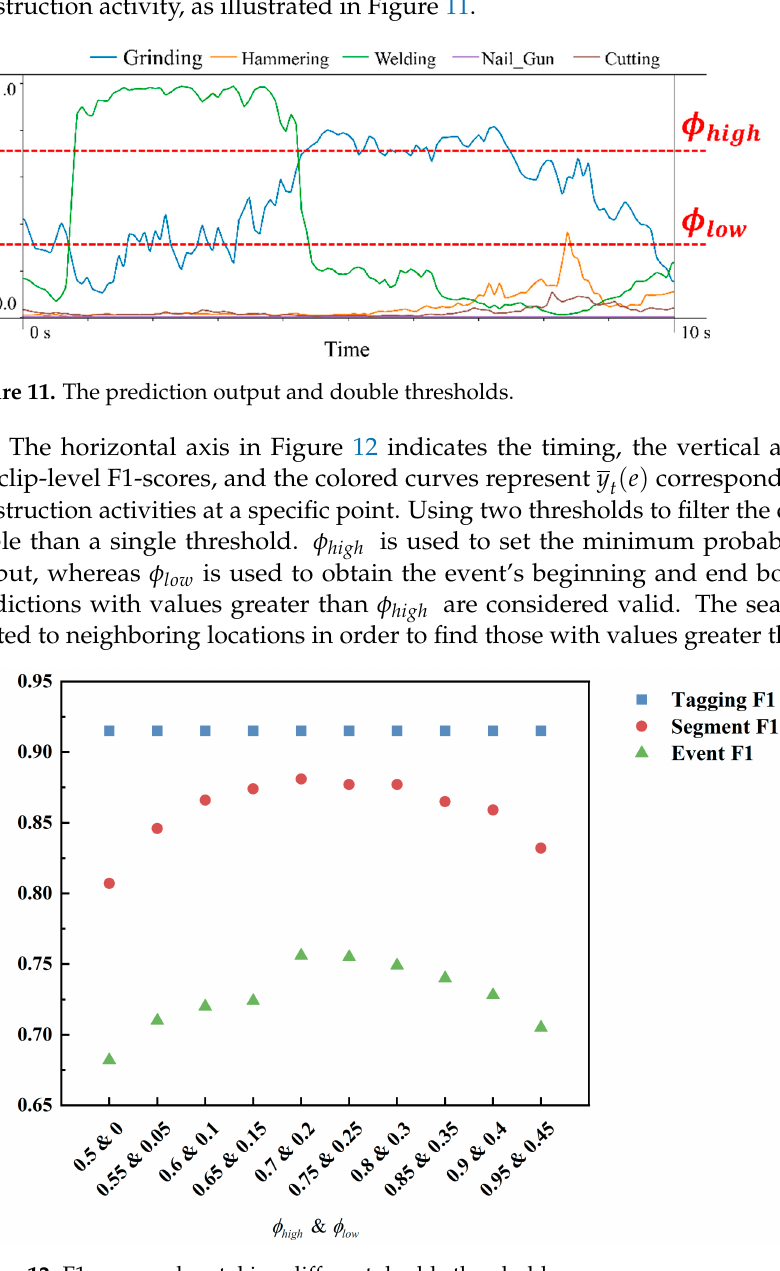
Figure 12. F1 scores when taking different double thresholds.